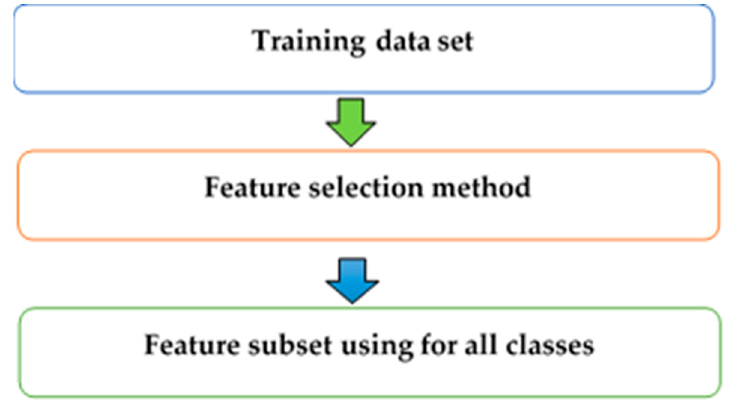
Figure 2. Class-independent feature selection technique.